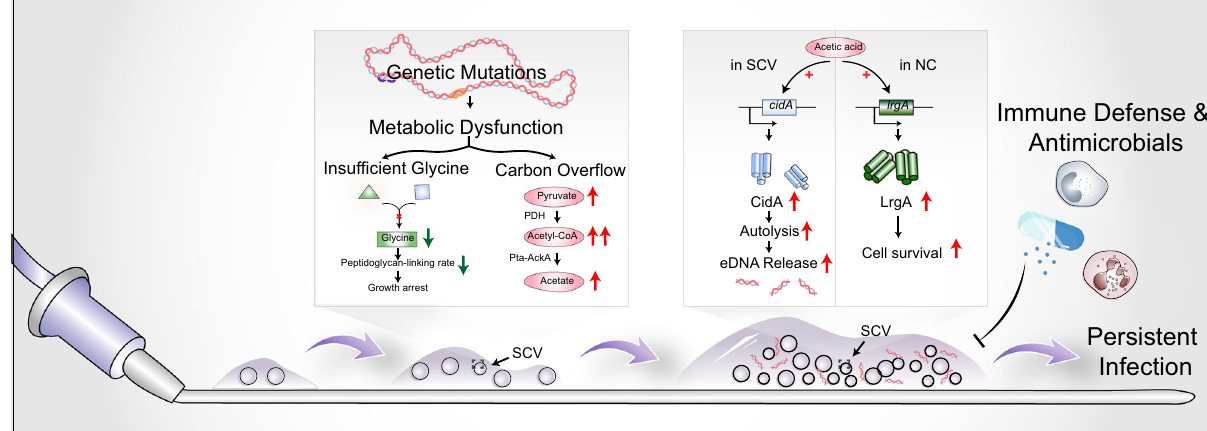
Fig. 8 Working model of the glycine-auxotrophic clinical S. epidermidis SCV isolate in the persistence of bio fi lm-related catheter infections. Under the exposure of antibiotics, SCV subpopulations emerge rapidly, accompanied by genomic variation and consequent metabolic dysfunction. Frameshift of AGXT1 in SCV potentially results in a defective glycine biosynthetic pathway, which leads to slow cell-wall building rate and consequent growth arrest. Over fl owed pyruvic acid and acetyl-CoA lead SCV to generate and release a higher level of acetic acid, which triggers cell autolysis of SCV cells but protects NC cells against lysis by upregulating cidA expression of SCV and lrgA expression of NC, thereby allowing SCV to far more quickly autolyze. Rapid autolysis of SCV leads to the leakage of intracellular contents such as DNA and enhances bio fi lm formation, which renders the whole population recalcitrant toward both host immune system and antimicrobial agents and more importantly, facilitates persistent